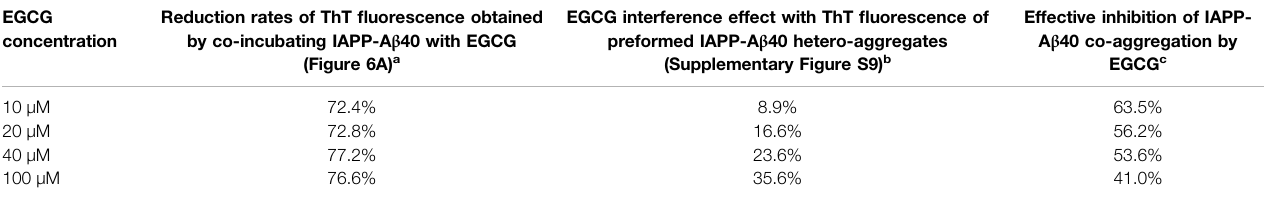
Effective inhibition of IAPP- A β 40 co-aggregation